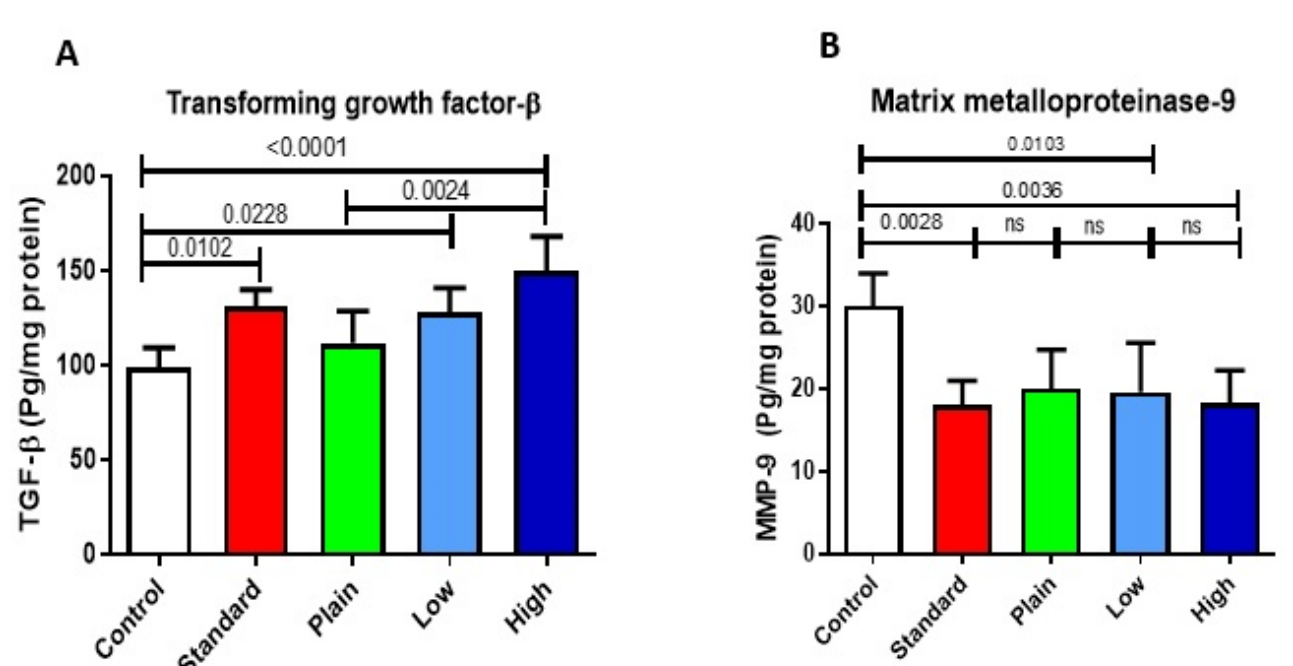
Figure 7. The effect of CuSQ hydrogel on quantitative analysis of the proliferative markers in the healed tissue at the sacrifice day as compared to standard gentamicin (0.1% garamycin cream); ma ‐ trix metalloproteinase (( A ), MMP ‐ 9), and transforming growth factor beta (( B ), TGF ‐β ). Data are represented as mean ± SD of at least 6 wounds. The exact p values are shown in the graph.